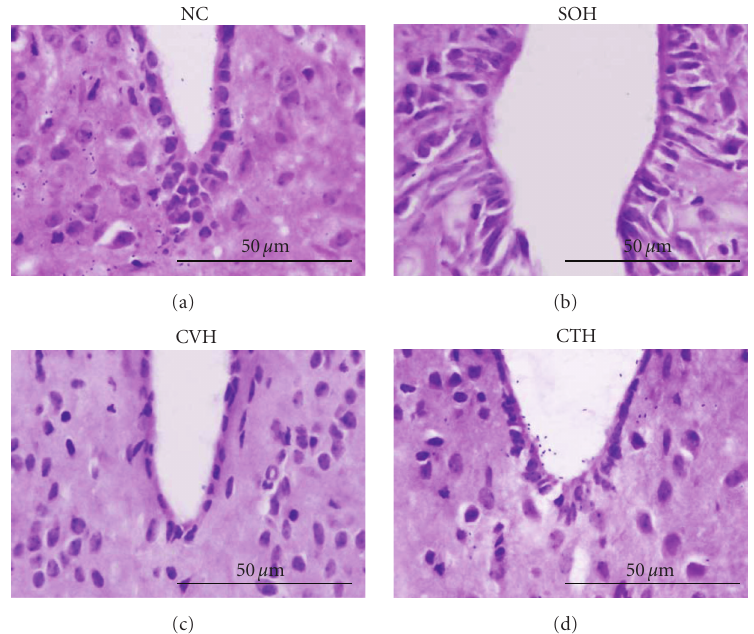
Figure 4: Photomicrographs of neuronal damage of the hypothalamus of a normothermic control (NC) (a), a sham-operated vehicle-treated heatstroke (SOH) mouse (b), a castrated, vehicle-treated heatstroke (CVH) mouse (c), and a castrated, testosterone-treated heatstroke (CTH) mouse (d). Two and half hours post-whole body heating, the hypothalamus of a SOH mouse or a CTH mouse showed cell shrinkage, pyknosis of the nucleus, and loss of Nissl substance. However, following castration, neuroprotection was induced (as shown in a CVH mouse) ×